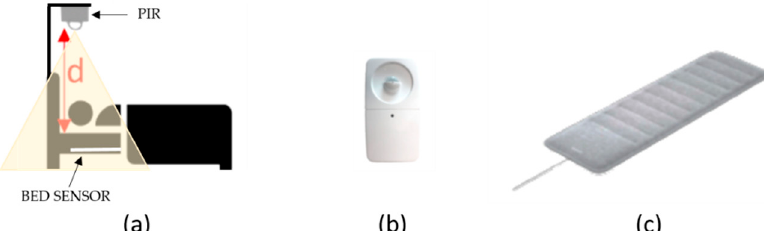
Figure 1. ( a ) The measurement set-up during the test nights with the user lying in bed and the Passive InfraRed PIR sensor installed at a distance d of 1.10 m above the pillow; ( b ) PIR sensor; ( c ) reference bed sensor (Nokia sleep bed sensor) installed under the mattress.